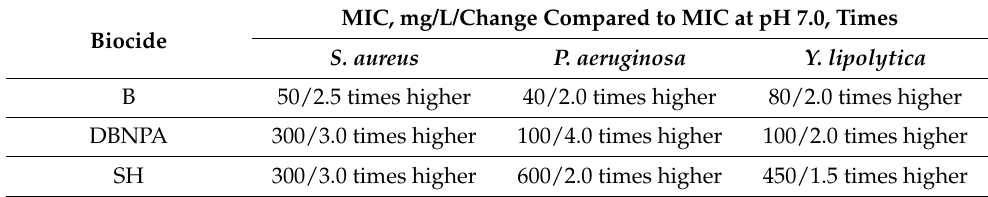
Table 3. MIC of the studied biocides for test-microorganisms at pH 9.0.